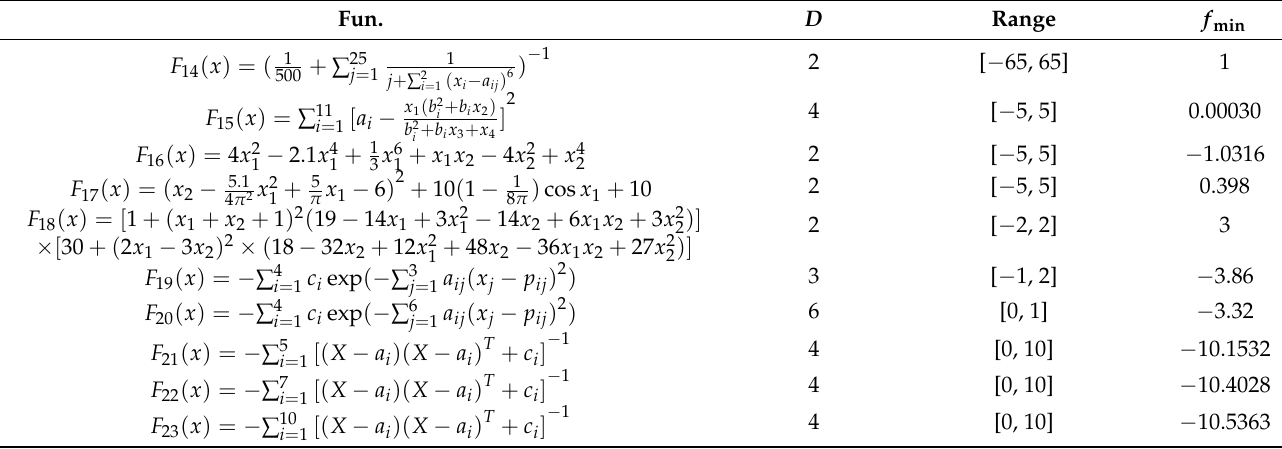
Table 4. Fixed-dimension multimodal benchmark functions. Fun. D f